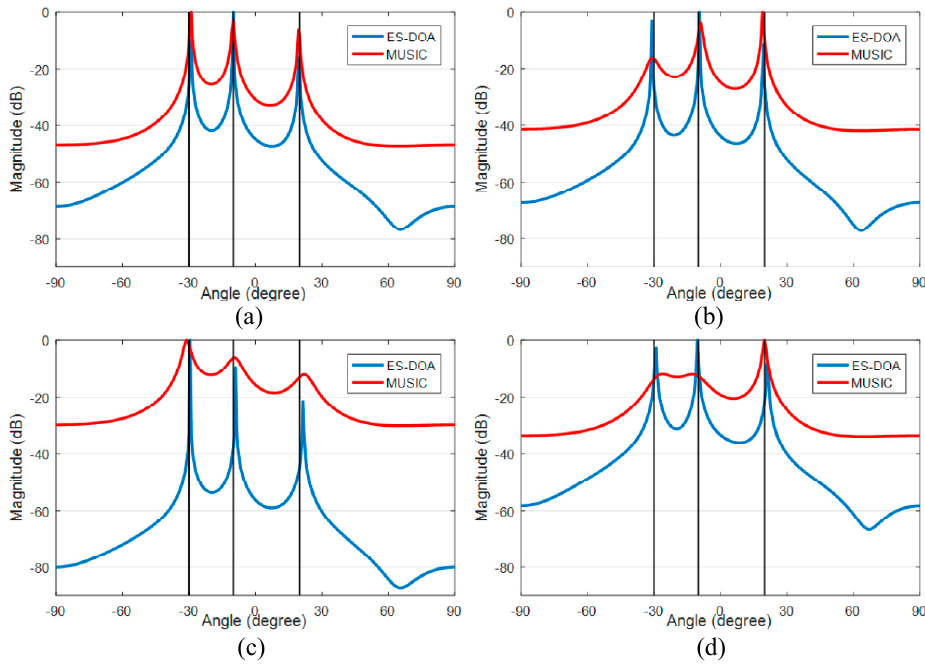
Figure 5. Azimuth spectrums of ES-DOA and MUSIC algorithms when SNR = 10 dB: ( a ) 1000 signal snapshots; ( b ) 200 signal snapshots; ( c ) 50 signal snapshots; ( d ) 10 signal snapshots.